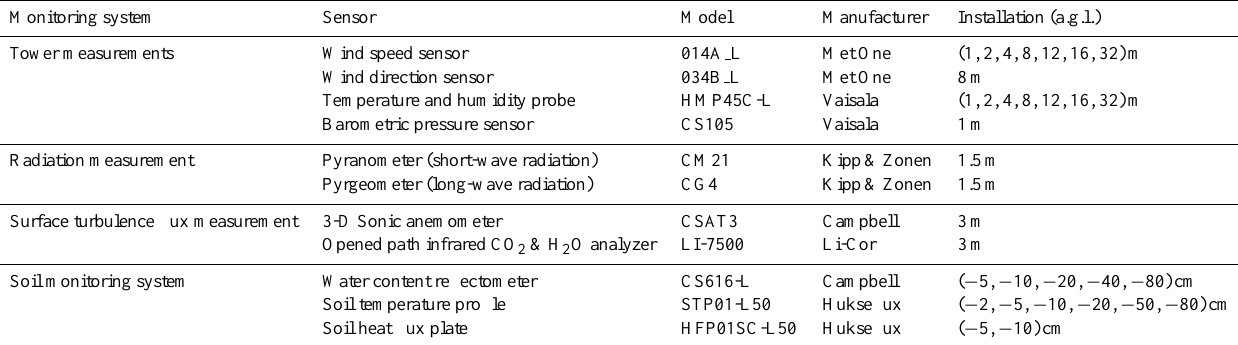
Table 1. Equipment installed at the SACOL